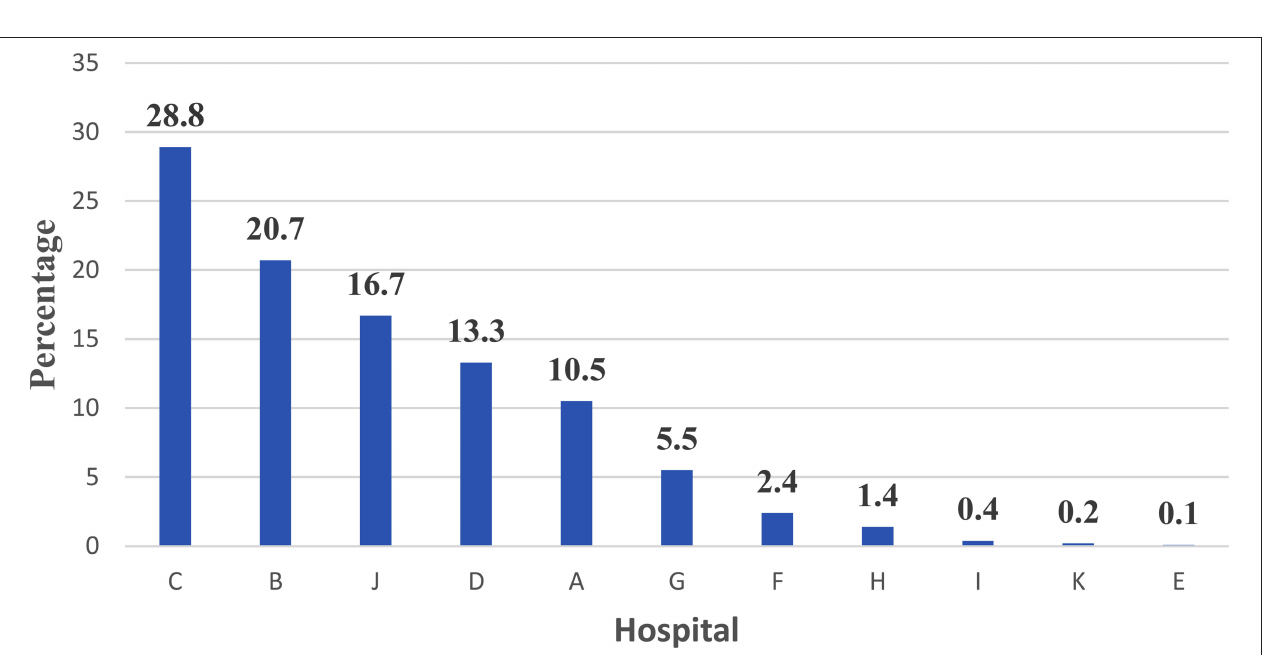
FIGURE 2 | Percent distribution of PCR confirmed COVID-19 across 11 Teaching hospitals among non-medical personnel—Egypt: (June 1 to July 15, 2020) —Rank ordering.